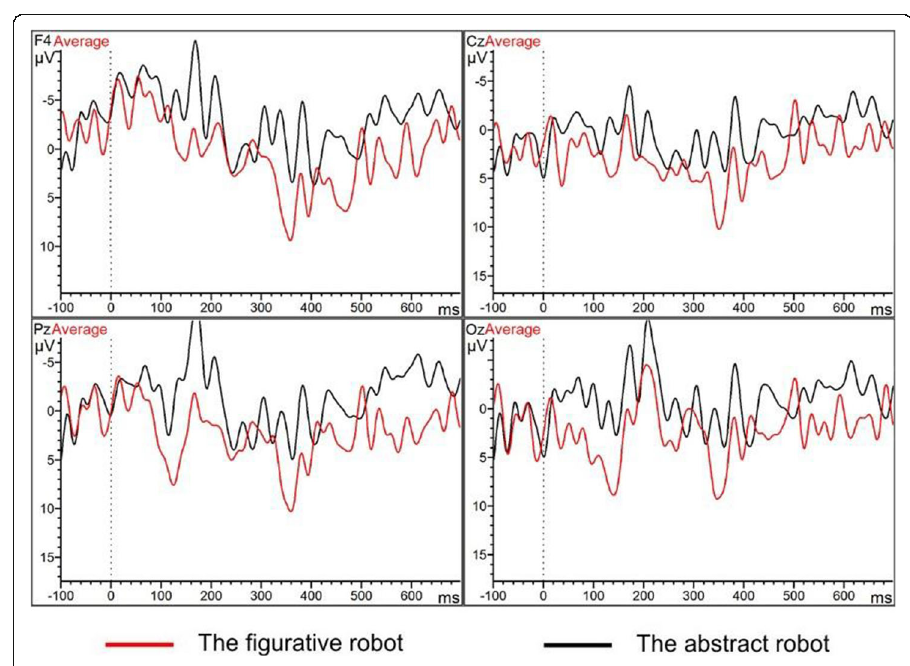
Fig. 4 Electroencephalogram topographic map of two types of